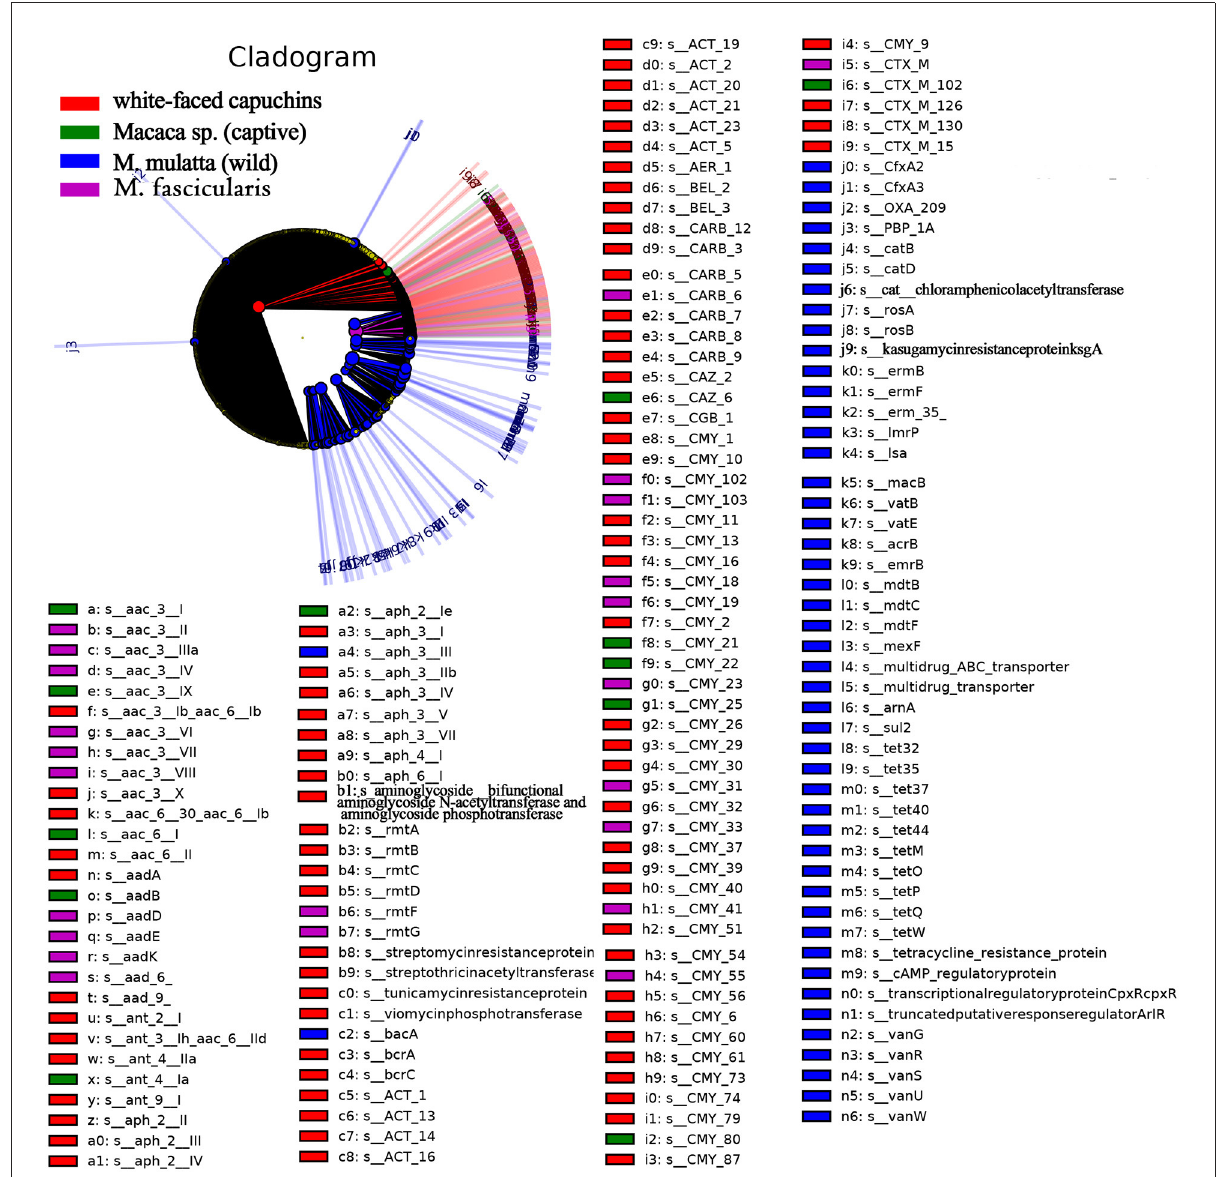
FIGURE5 Cladogram of the significantly different ARGs between white-faced capuchins, Macaca sp. (captive), M. mulatta (wild) and M. fascicularis samples. The inner circles are at the ARG type level, while the outer circles are at the subtype